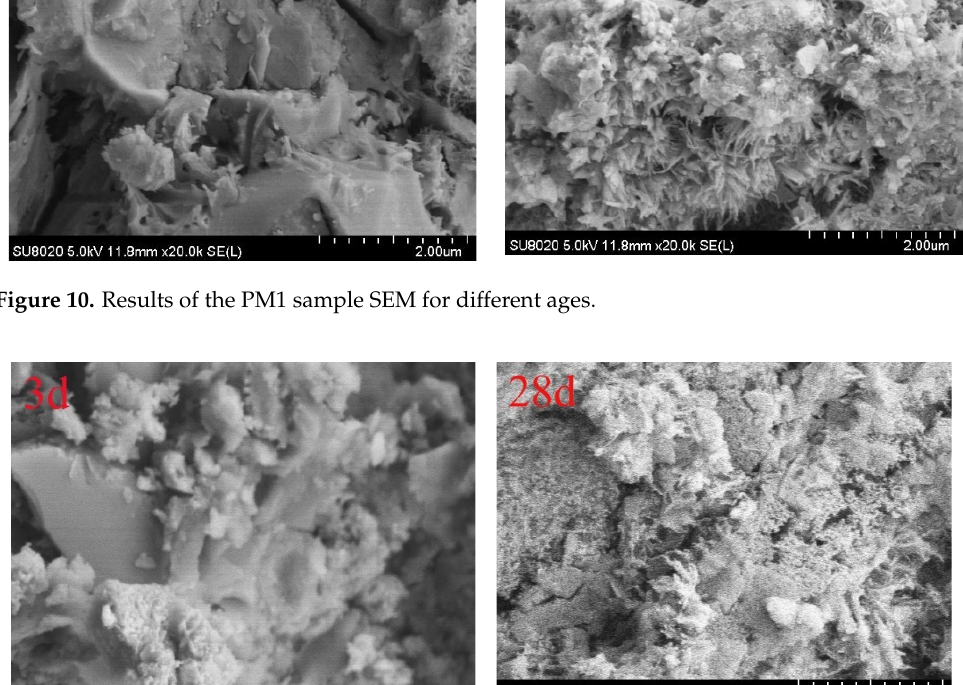
Figure 10. Results of the PM1 sample SEM for different ages.